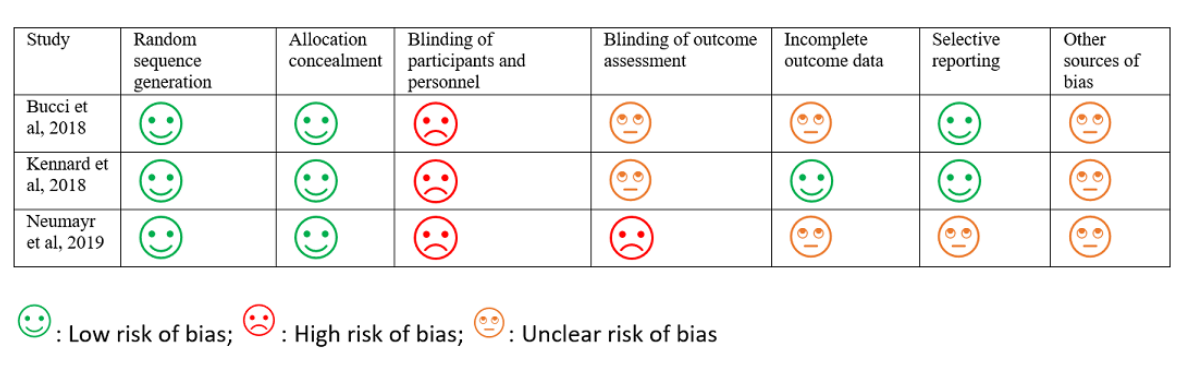
Figure 2. Cochrane risk of bias assessment chart for the included randomized controlled trial studies.